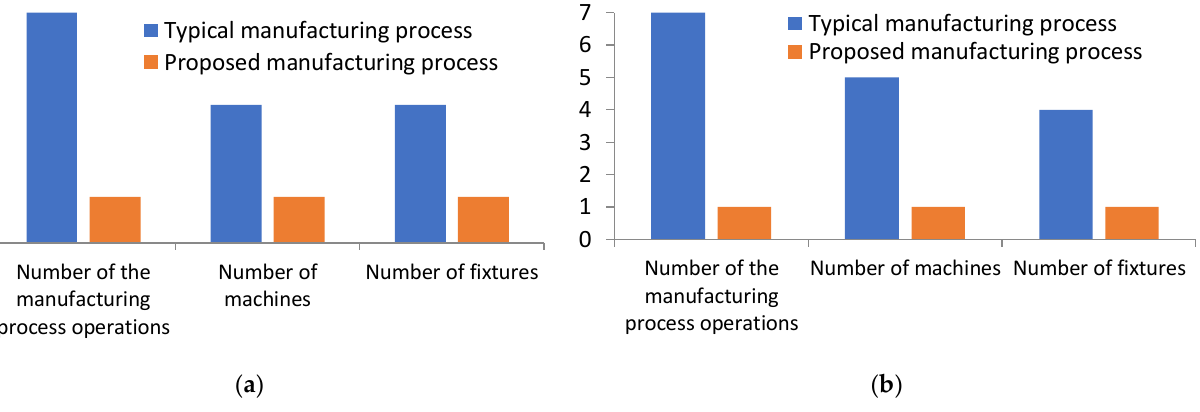
Figure 2. Diagram comparing manufacturing process indicators: ( а ) One-piece connection rods; ( b ) One-piece clip connection rods.